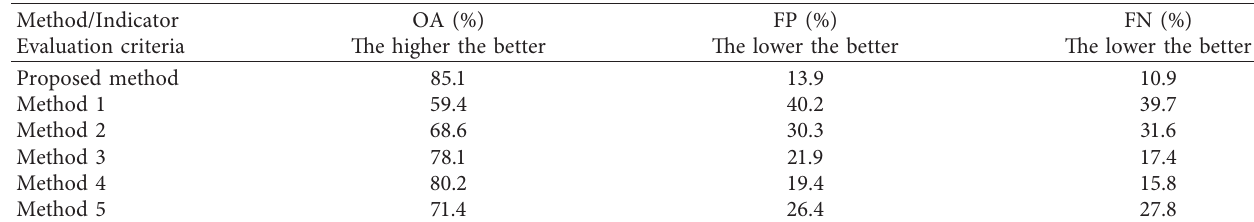
Table 6: Quantitative evaluation of CD accuracy in dataset